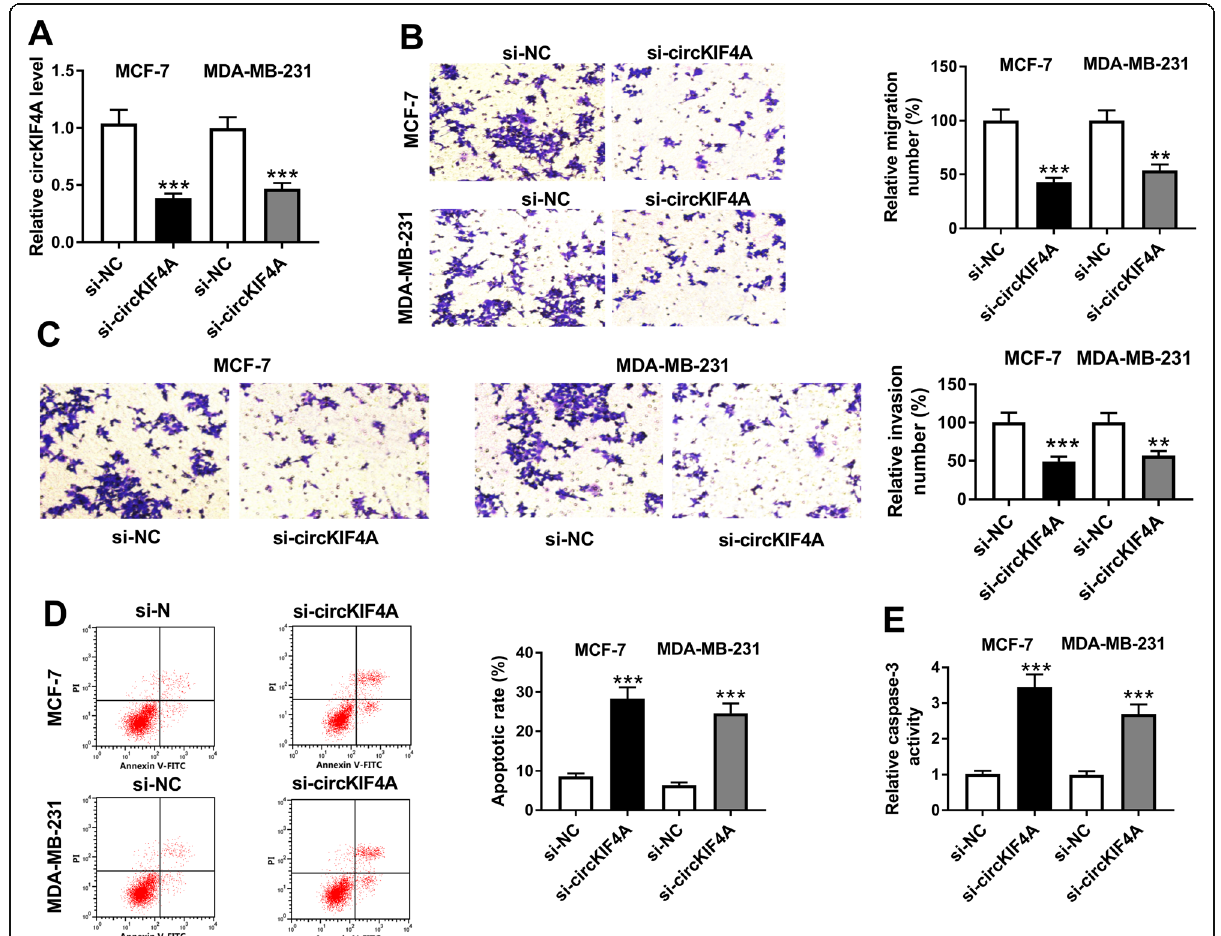
Fig. 2 CircKIF4A knockdown hampered BC cell migration, invasion and promoted apoptosis. MCF-7 and MDA-MB-231 cells were treated with si- circKIF4A or si-NC. ( a ) CircKIF4A level was measured using qRT-PCR. ( b, c and d ) Cell migration, invasion and apoptosis were detected by transwell assay or flow cytometry analysis. ( e ) The level of caspase-3 was measured via qRT-PCR. **P < 0.01, ***P <